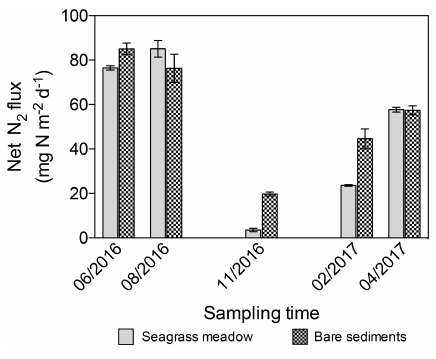
Figure 6. Net N 2 flux in seagrass meadow (gray) and bare sedi- ment (square pattern gray) throughout the year, considering sedi- ment denitrification and anammox as N losses and sediment and seagrass roots and epiphytes N 2 fixation as new N inputs. Error bars indicate SEM.